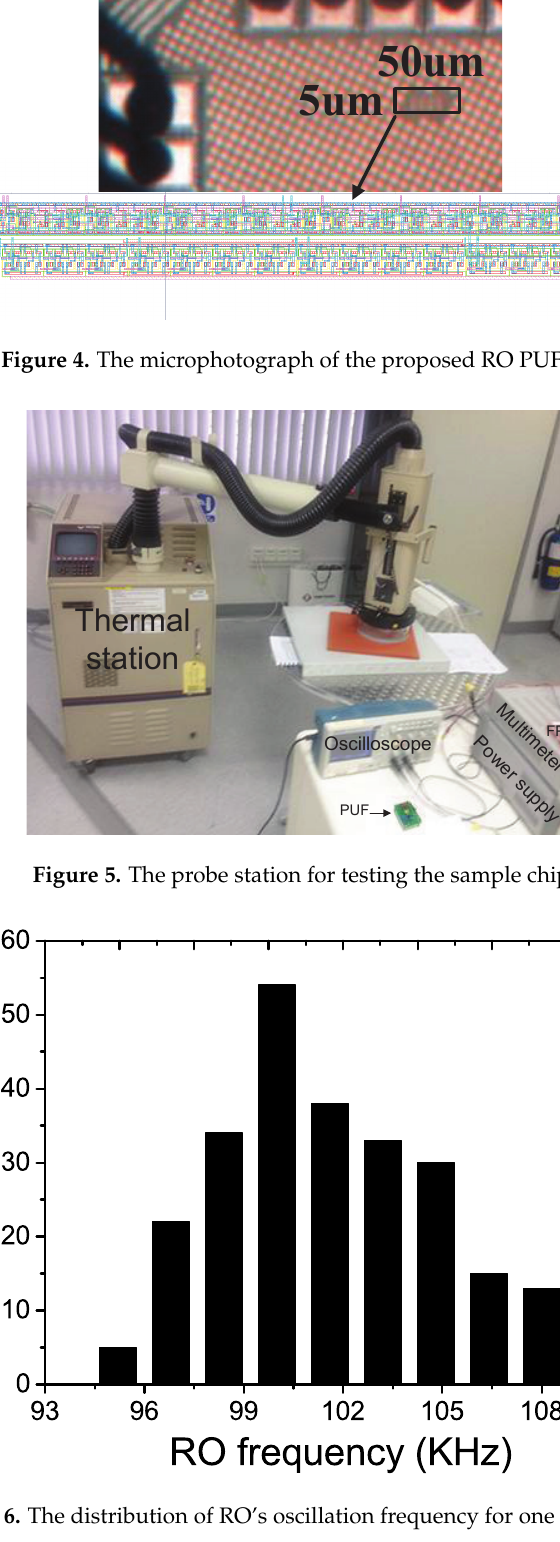
Figure 6. The distribution of RO’s oscillation frequency for one sample